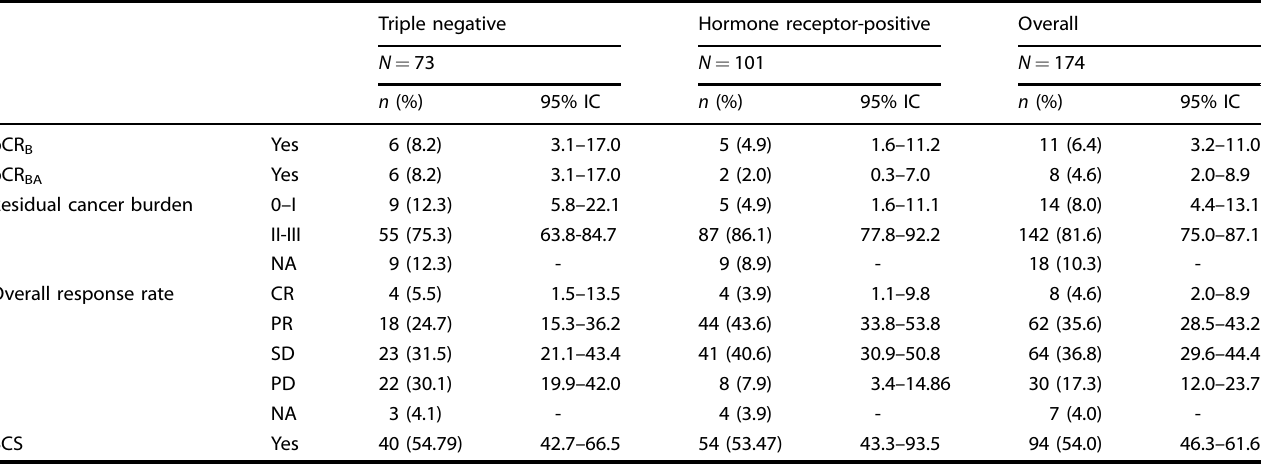
Table 2. Secondary endpoints determined at